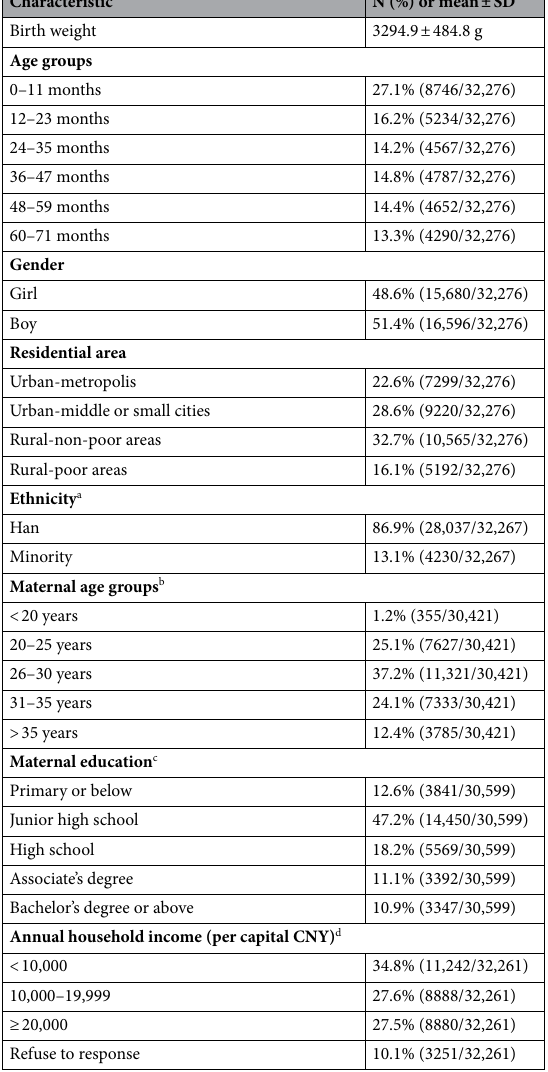
Table 1. Demographic and socioeconomic characteristics of the subjects. a The ethnic information for 9 subjects was missing. b Information on maternal age was missing in 1855 subjects. c Information on the maternal educational level was missing in 1677 subjects. d Information on the annual household income was missing in 15